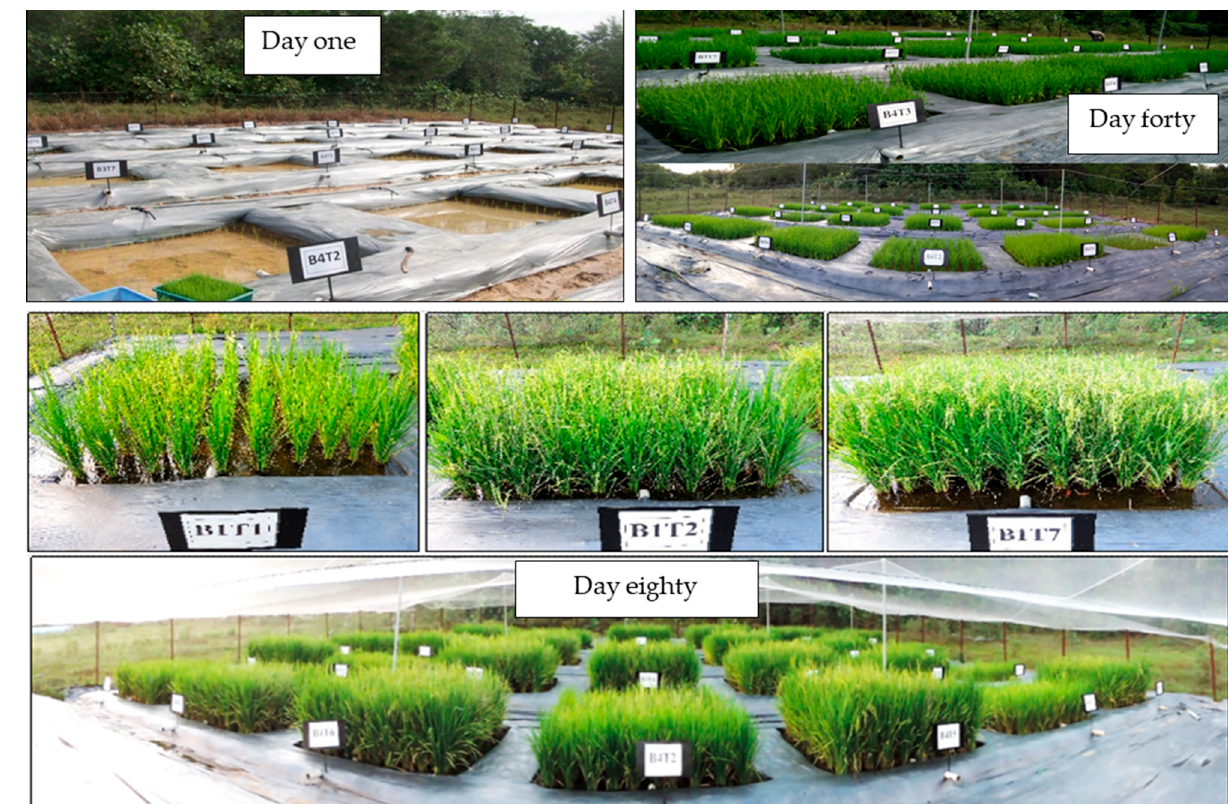
Figure 2. Rice seedlings in relation to treatments at different growth stages after transplanting.